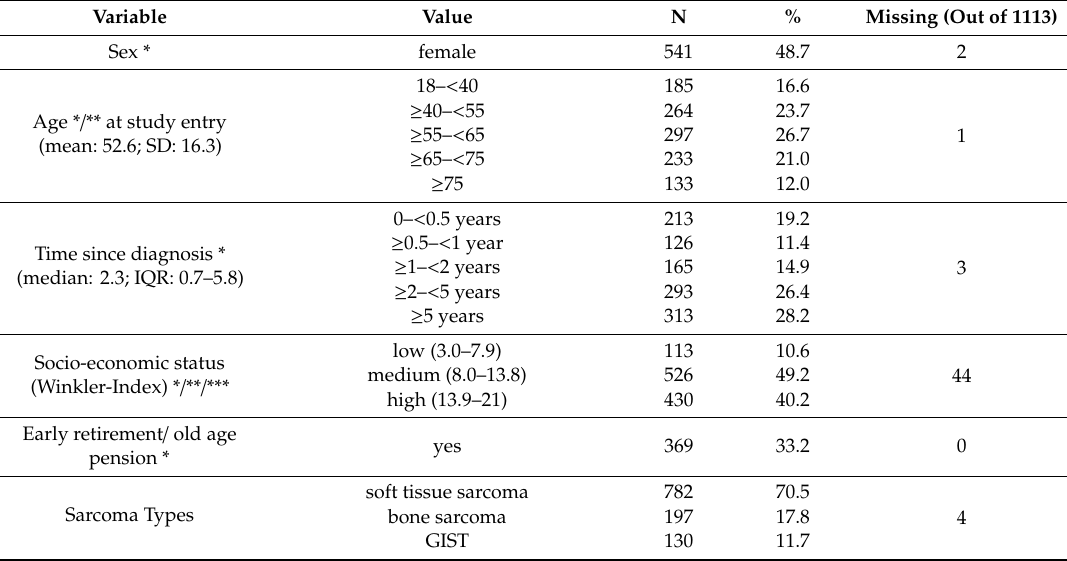
Figure 1. Study participation. Number of patients contacted overall had to be extrapolated from numbers of reporting study centers because not every study center documented contacted patients. Table 1. Description of study